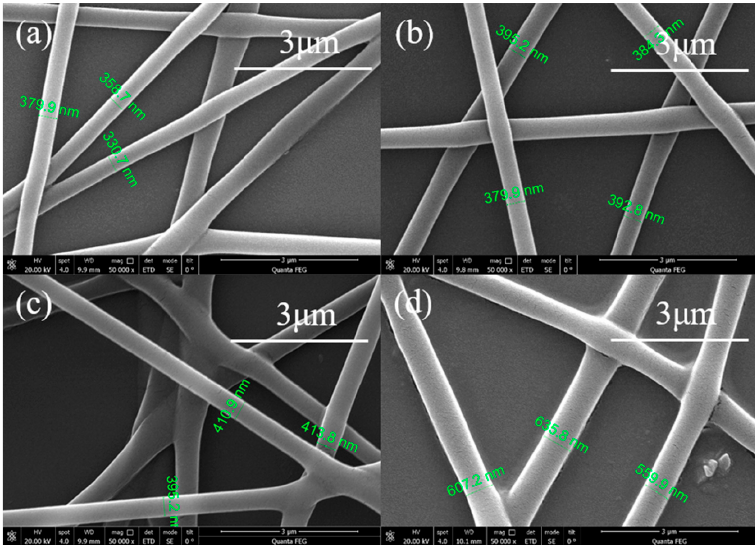
Figure 3. SEM image of PVA electrospinning nanofibers at different injection speed. ( a ) 0.0010 mm/s ( b ) 0.0015 mm/s ( c ) 0.0020 mm/s ( d ) 0.0025 mm/s.